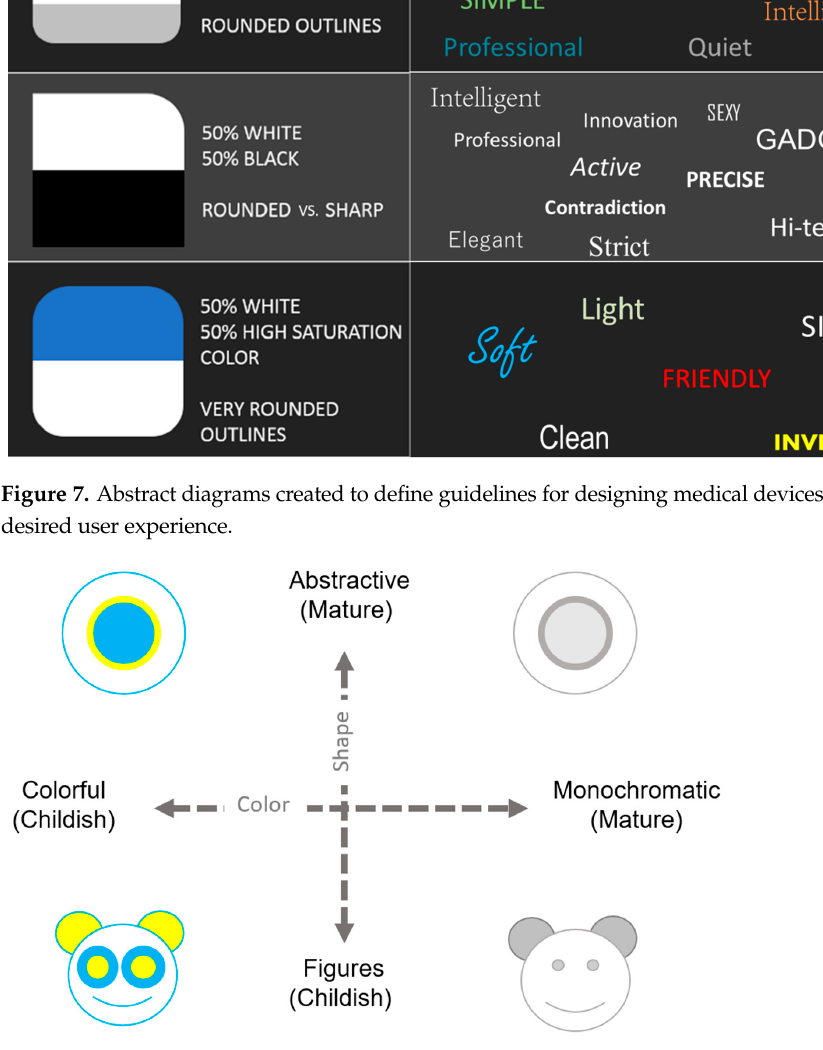
Figure 8. A graph presenting the appearance spectrum for the design of medical devices for children.